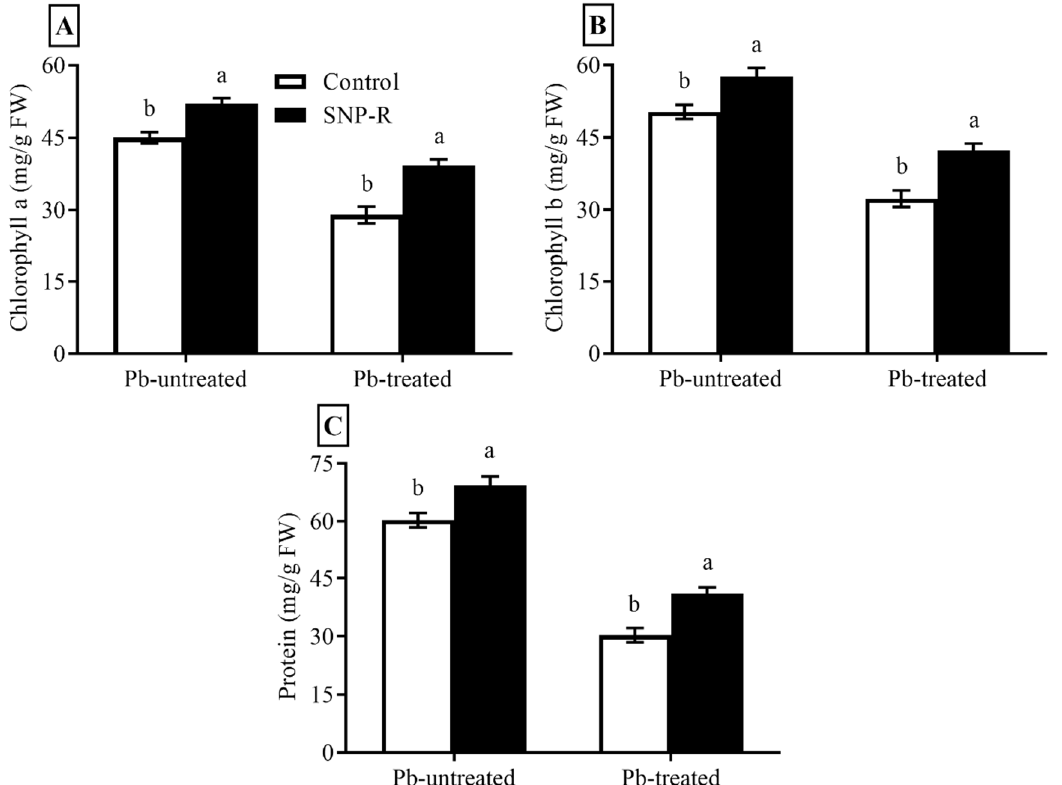
Figure 2. Effect of exogenously applied SNP on rice with or without Pb-induced stress. ( A ) Chloro- phyll a content; ( B ) chlorophyll b content; ( C ) protein content. Each data point indicates the mean ± standard deviation ( n = 3). Bars with different letters indicate significant differences, according to Duncan’s multiple range test. The results are compared to the respective controls (Pb-untreated and Pb-treated plants).